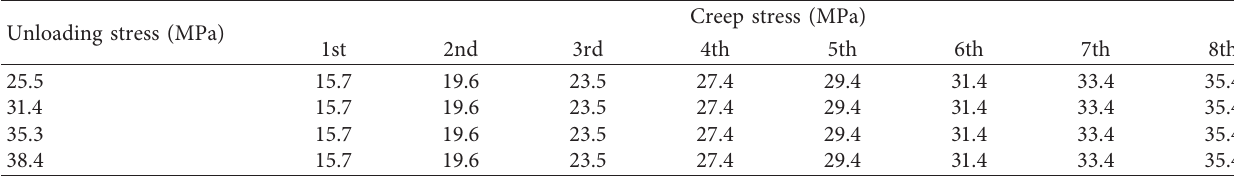
Figure 3: Stress-strain curve of sandstone and unloading stress levels. Table 1: Unloading stress and creep stress